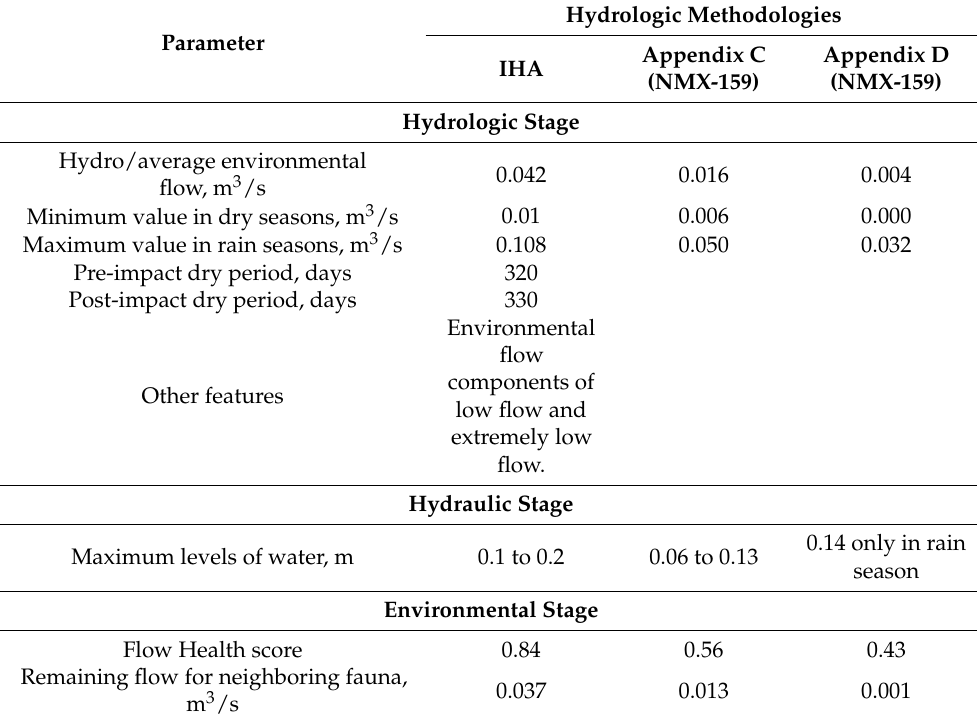
Table 7. Comparative results from hydrologic methodologies for each block of study.